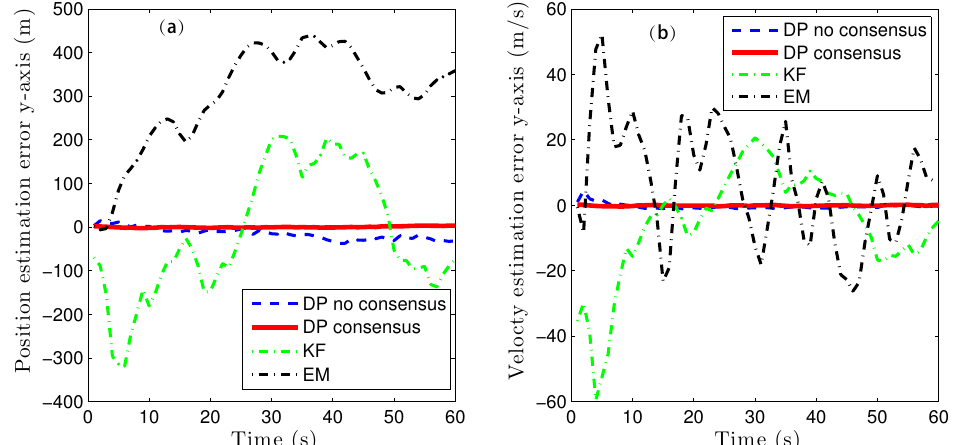
Figure 15. State estimation errors in the y direction using the KF, DP consensus, DP no consensus and EM methods for sensor 4 in the multi-sensor system of 60 sensors. ( a ) position estimation; ( b ) velocty estimation.